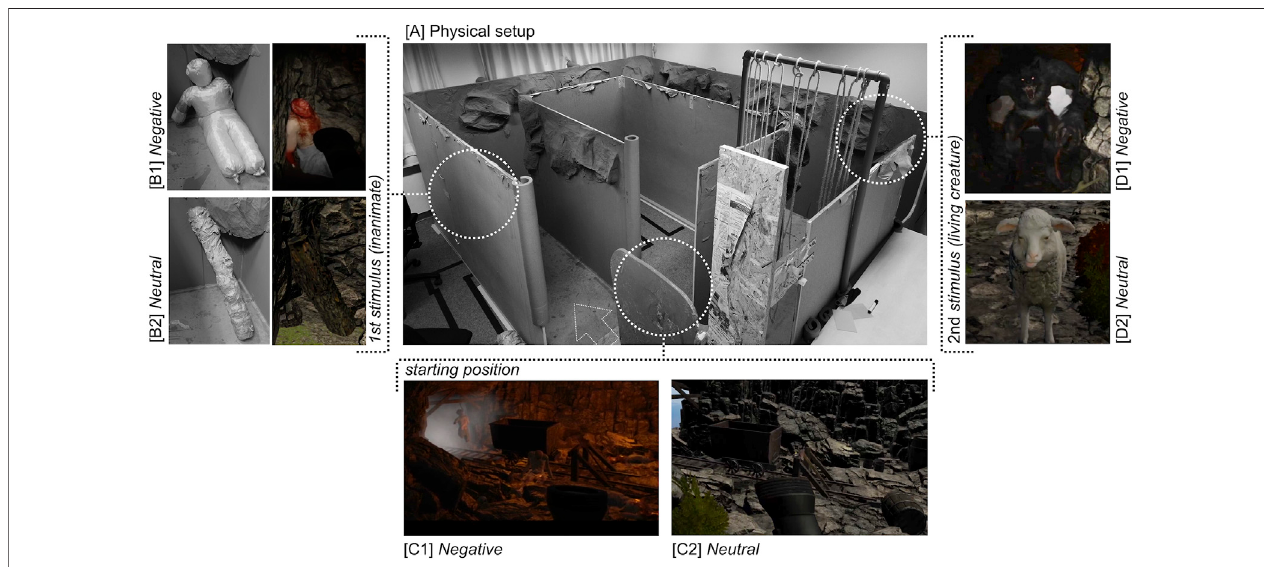
FIGURE 1 | Illustration of the (physical) cave and respective stimuli per condition. Panel (A) depicts the physical replica of the cave which participants walked through. The dotted white arrow indicates the initial direction in which the participants moved through the cave. The position of relevant creatures/objects in their virtual and physicalform (seepanels (B) and (D) )areindicatedrespectively.Thecave ’ sentrance area(panel C )served asanindicatorofwhatenvironmentwastobeexpected. It gave participants an immediate chance to terminate the experiment.